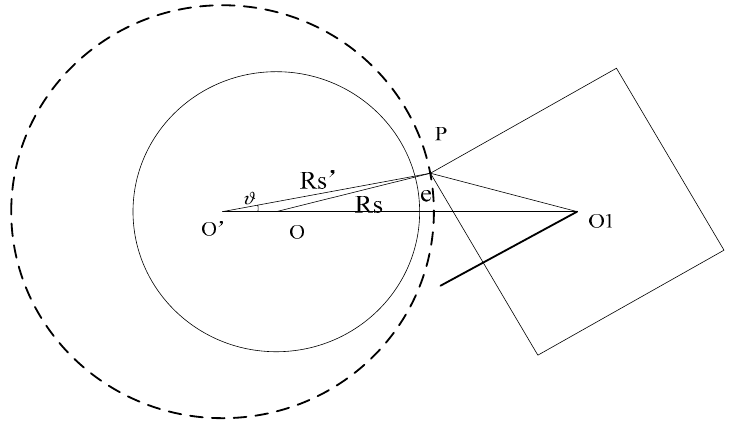
Figure 3. Diagram of influence of grinding wheel diameter decrease on dimensional error.